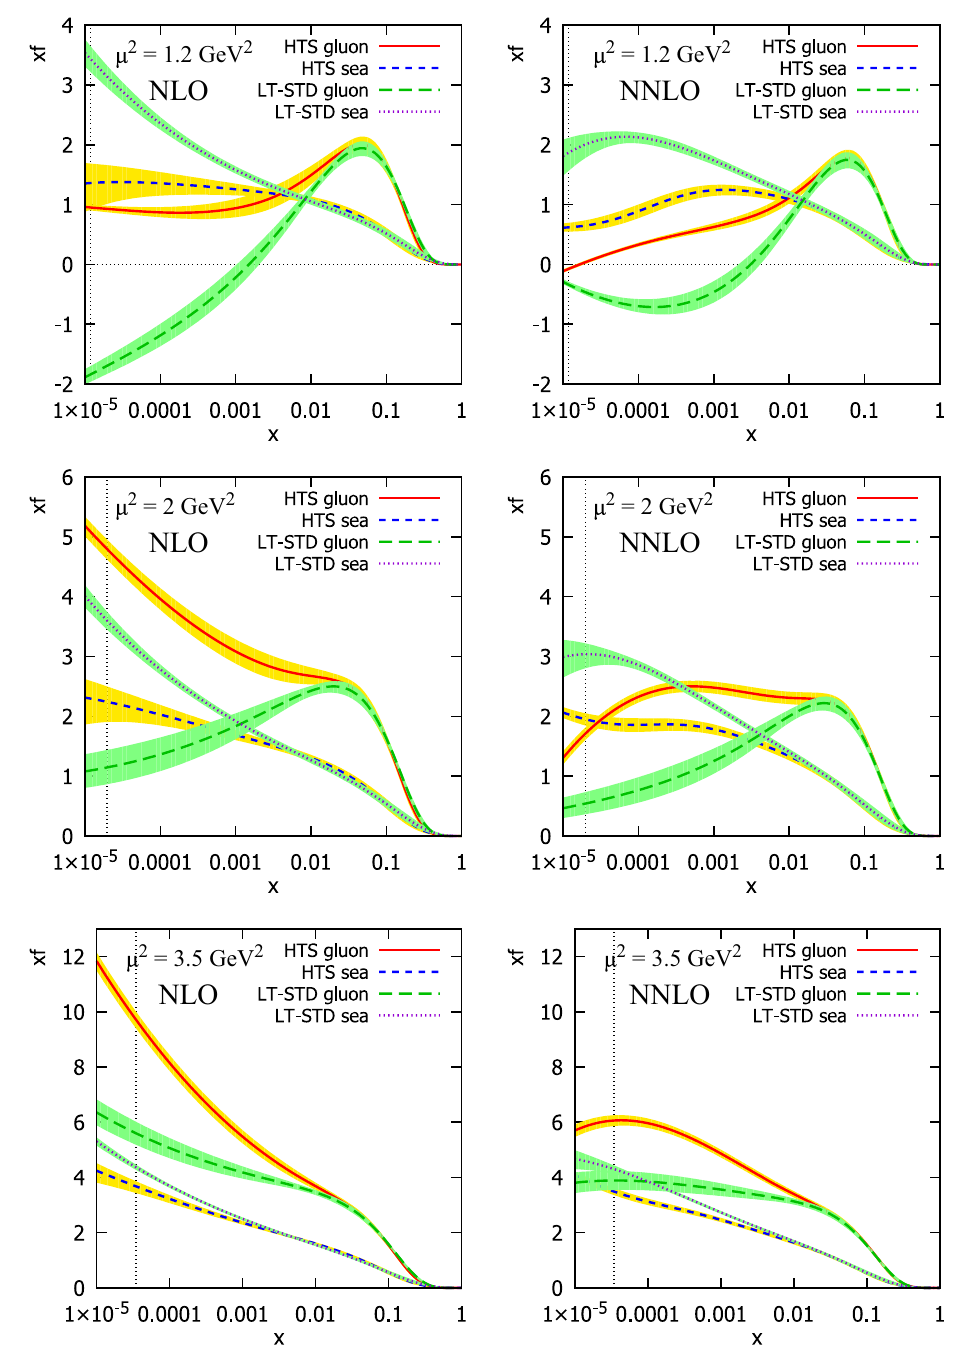
Fig. 7 Comparison of the HTS and LT-STD PDFs at μ 2 = 1 . 2GeV 2 (top), μ 2 = 2 . 0GeV 2 (middle) and μ 2 = 3 . 5GeV 2 (bottom). For μ 2 = 1 . 2GeV 2 the LT-STD PDFs are extrapolated below the parameterisation range. The experimental uncertainties are